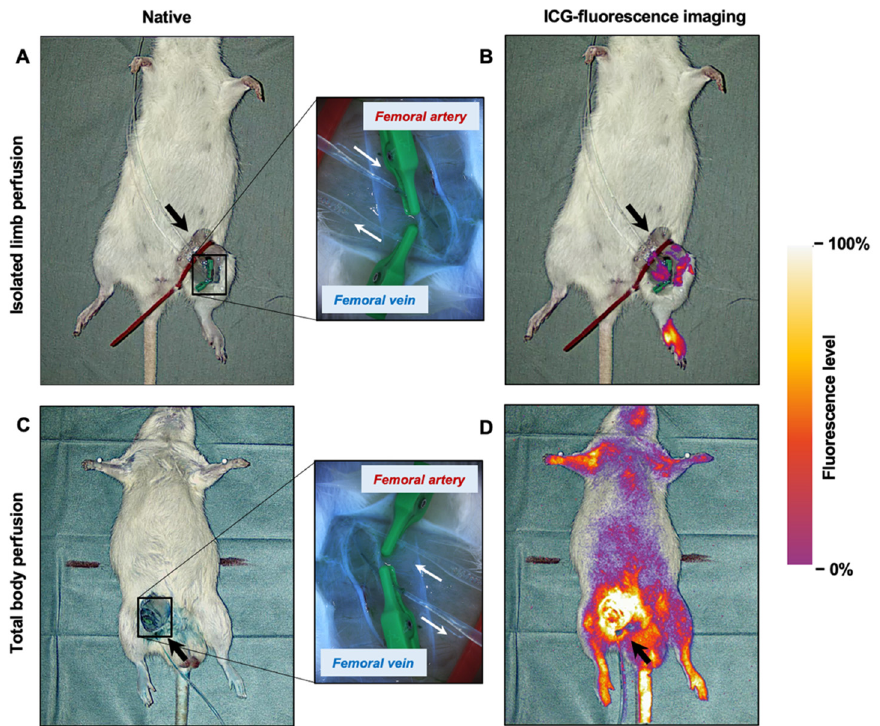
Figure 1. ICG-fluorescence imaging as indicator of ILP. ( A ) The native image shows the cannulation site: the femoral artery and vein are cannulated for perfusion inflow and outflow. The arrow indicates the direction of the flow. Clamps are used to keep the cannulas in place, and a magnification (4 × ) of the cannulation site is provided for a better overview. ( B ) ILP is demonstrated with ICG fluorescence imaging. ( C ) For comparison, a native picture of a rat cadaver with whole-body perfusion is shown. In this case, the direction of flow is inverted (arrow). A magnification of the cannulation site is provided (4 × ). ( D ) ICG fluorescence imaging of whole-body perfusion evokes a glowing signal of the entire body, while the cannulated extremity is spared. Fluorescence level is indicated by brightness and color: areas with the smallest penetration depth result in the highest fluorescence signal, e.g., areas uncovered by fur or skin, such as the cannulation site.